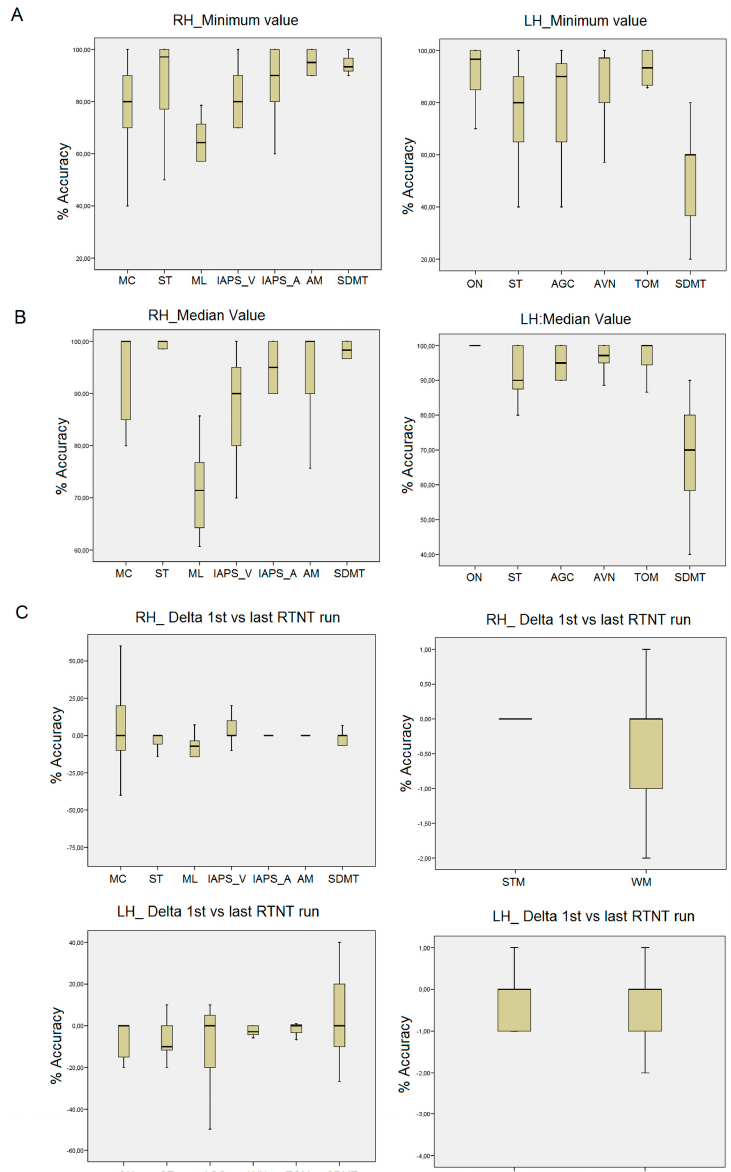
Figure 2. Patients’ RTNT performance during resection. The minimum value ( A ), median value ( B ), and delta (1st vs. last RTNT run, ( C )) for RH and LH groups are shown. MC = Metaphor comprehension; ST = Stroop test; ML = Milner landmark test; IAPS_V and IAPS_A = international affective picture stimuli, valence and arousal; AM = attentive matrices; SDMT = symbol digit modality test; STM = short-term memory; WM = working memory; ON = object naming; AGC = auditory grammar comprehension; VF = verbal fluency; AVN = action verb naming; TOM = theory of mind.